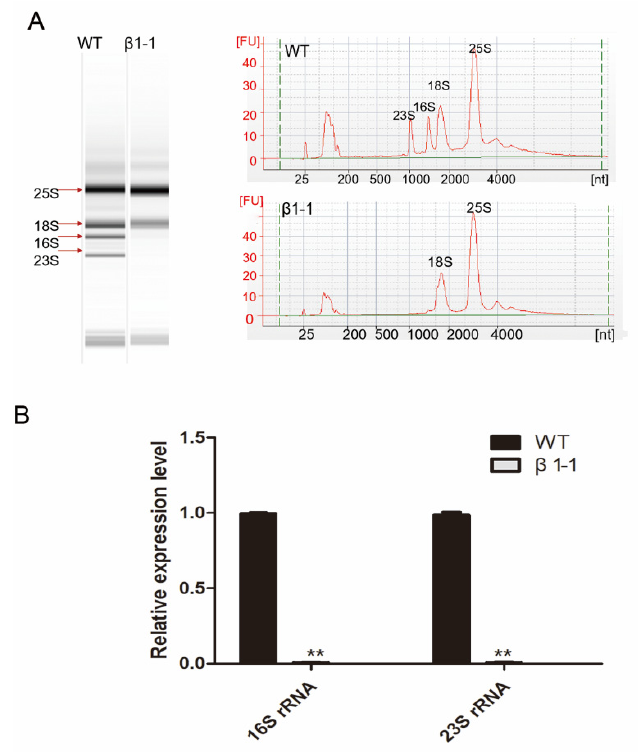
Figure 10. OsCpn60 β 1 affects the development of chloroplast ribosome. ( A ) rRNA analysis using an Agilent 2100 bioanalyzer. The rRNAs isolated from 7-day-old WT and OsCpn60 β 1 mutants seedlings. ( B ) qRT-PCR analysis of rRNA accumulation in WT and OsCpn60 β 1 mutants seedlings. The data are mean ± SD (n = 3) and ** indicates statistical significance at p < 0.01.